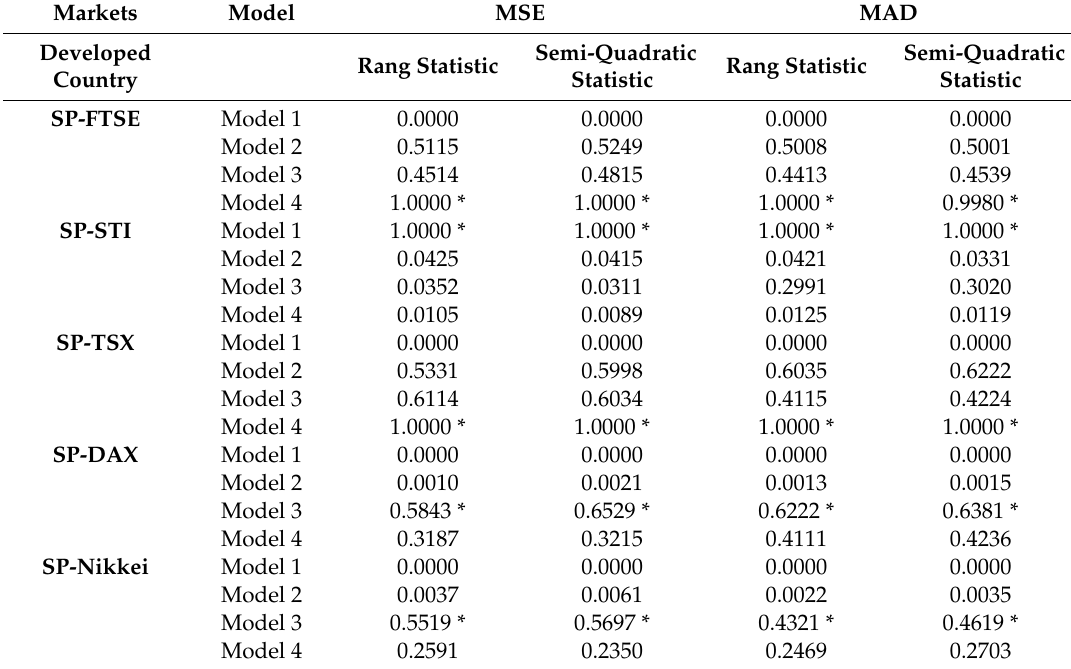
Table 9. The out-of-sample evaluation of forecasts of correlation for 10 stock market